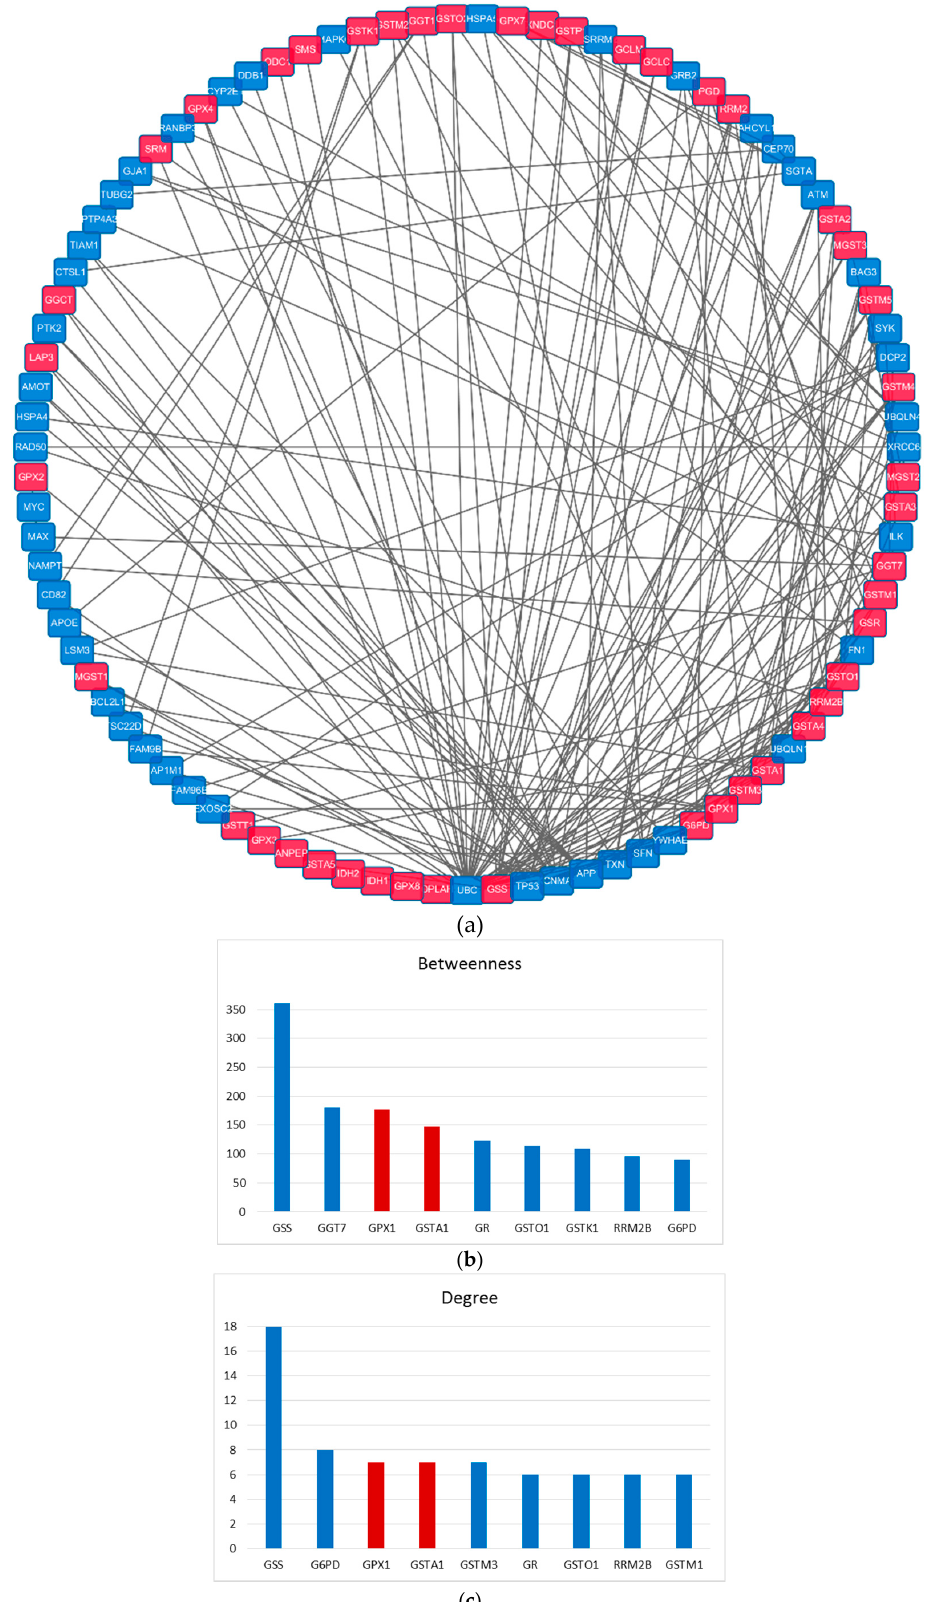
Figure 3. Cont. Figure 3.